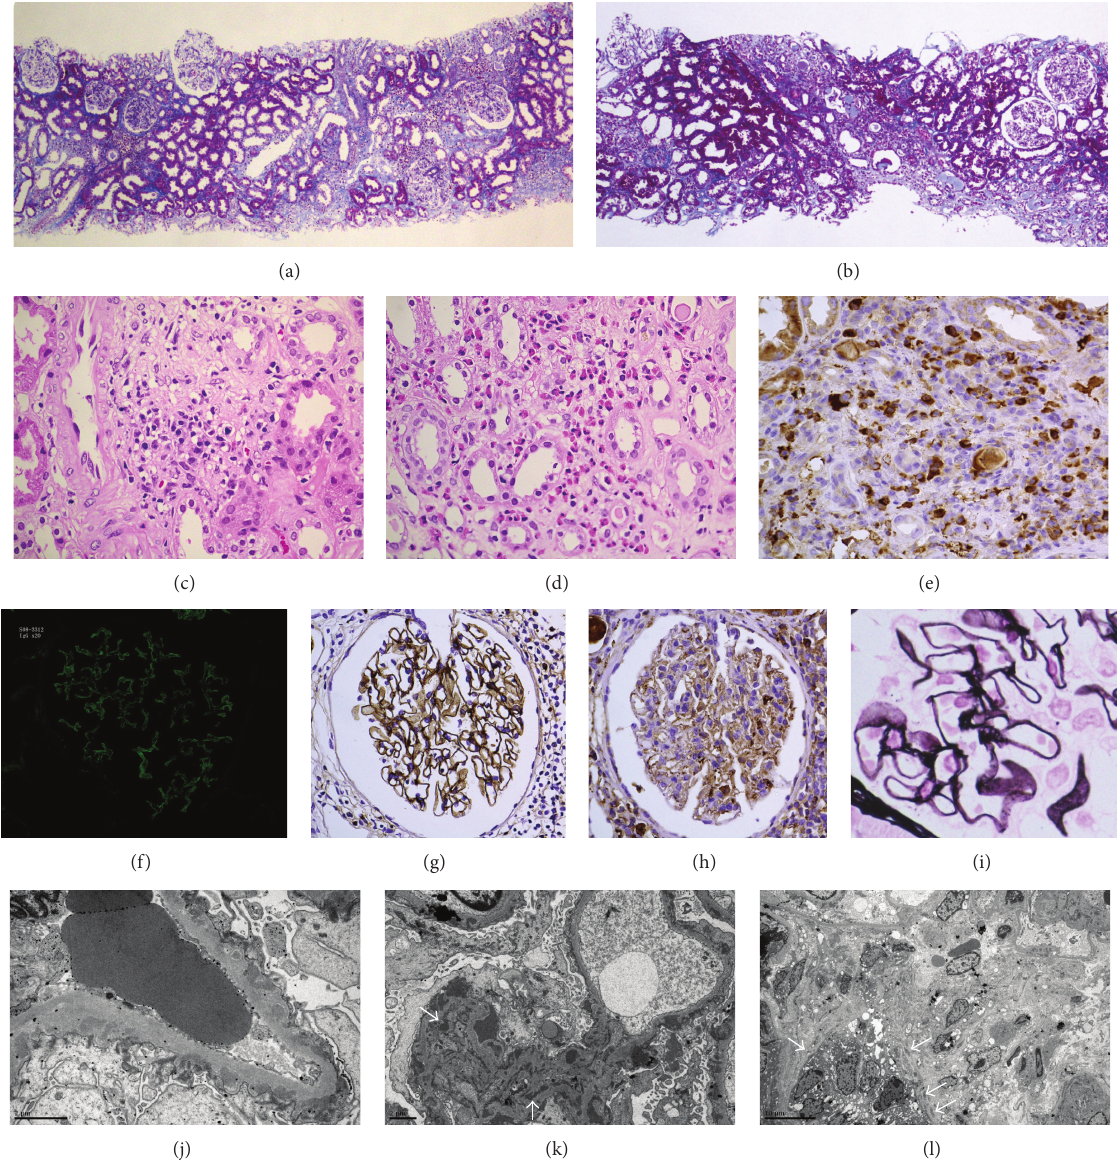
Figure 1: Representative microscopic histology. (a) Patchy infiltration of inflammatory cells and fibrosis in the interstitium with a clear border. Case 1. Masson trichrome stain, × 40. (b) Case 2. Masson trichrome stain, × 40. (c and d) Predominant infiltration of lymphocytes, plasma cells, and eosinophils into the interstitium. Case 1. H&E stain, × 400. (e) IgG4-positive plasma cells in the interstitium. Case 2. IgG4 immunoperoxidase stain, × 400. (f) Granular capillary wall staining for IgG. Case 1. Immunofluorescence, × 200. (g) IgG staining along the glomerular basement membrane (GBM). Case 1. IgG immunoperoxidase stain, × 400. (h) Weakly positive IgG4 staining along the GBM. Case 1.IgG4immunoperoxidasestain, × 400.(i)ThickenedGBMwithspikes.Case1.Periodicacidsilver-methenaminestain, × 400.(j)Subepithelial electron-dense deposits. Case 1. × 20,000. (k) Subepithelial and mesangial electron-dense deposits. Case 2. × 10,000. (l) Scattered tubular basement membrane deposits. Case 2. ×